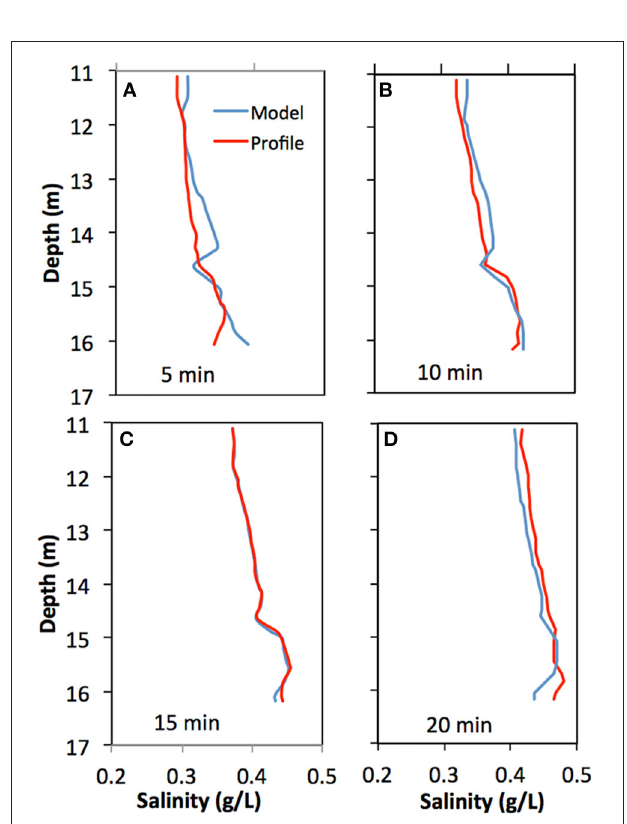
the estimation of their corresponding conductivity values were high around this well due to relatively high porous media conductivity near 16 m of depth. The hydraulic conductivity values were almost similar throughout the well, and it had a slightly higher flow rate at the bottom of the well. The hydraulic conductivities were observed in the range of 5 × 10 − 4 to 3 × 10 − 3 m/s ( Table 1 ). Although these